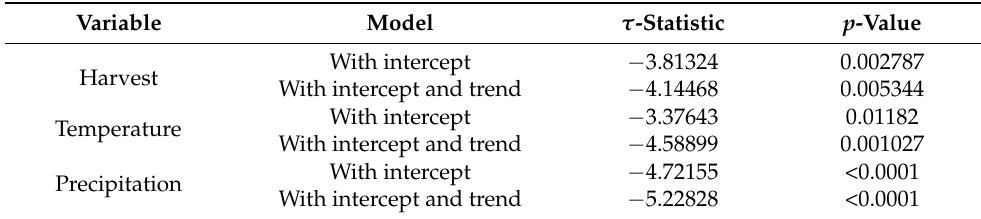
Table 4. Augmented Dickey–Fuller test for variable harvest, temperature, and precipitation.